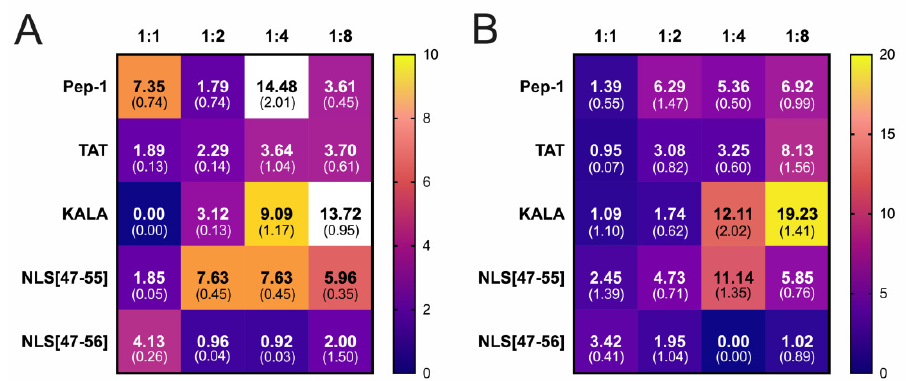
Figure 16. Results of 48 h culture in the presence of complexes in CRs of 1:1, 1:2, 1:4 and 1:8. The complexes were formed using incubation of 2 μ g pmaxGFP with chosen CPPs at 37 °C for 15 min. Bar = 50 μ m. CR, charge ratio.